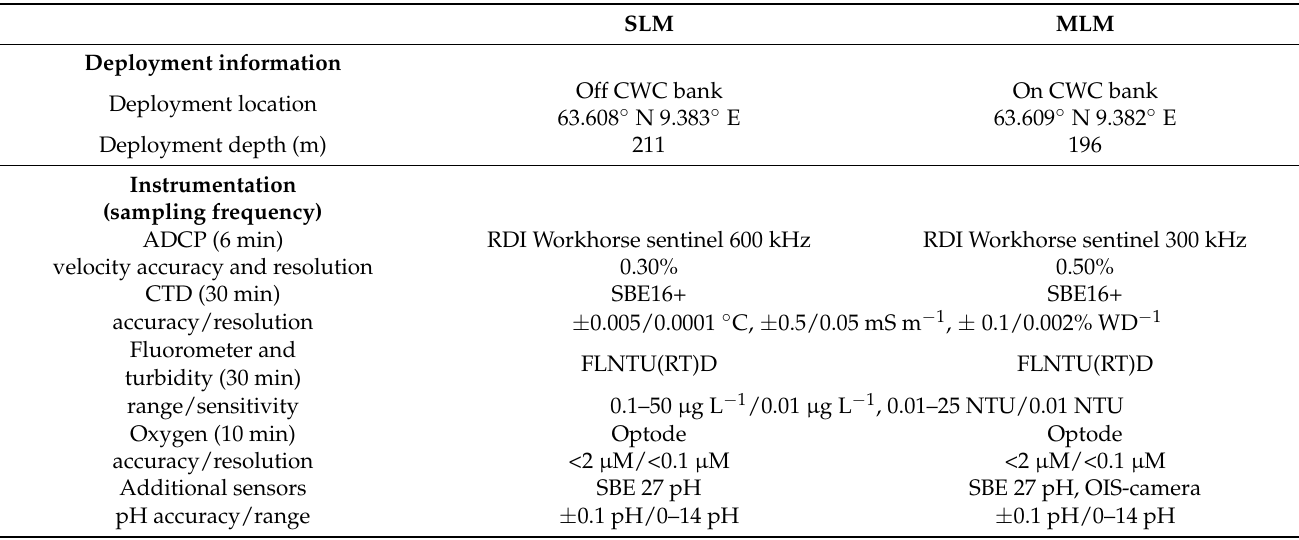
Table 2. Instrumentation details and metadata for landers deployed at Nakken bank reef area. Abbreviations: WD: water